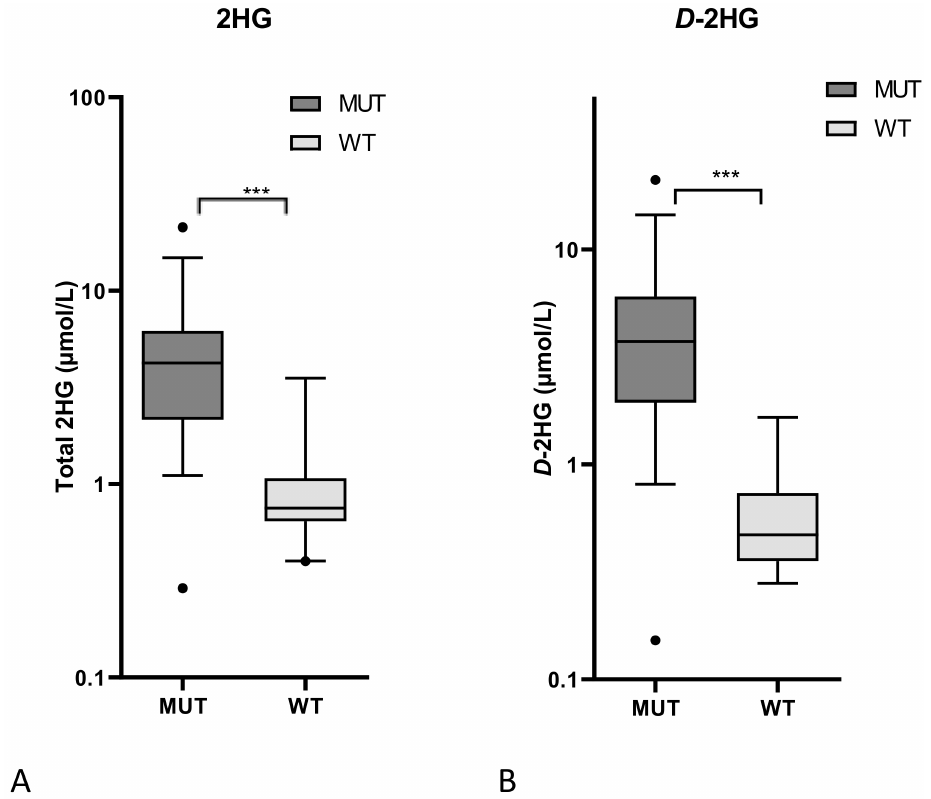
Figure 3. Serum concentrations of ( A ) total 2HG and ( B ) D -2HG was 5.6 ± 1.3 µ mol/L and 5.3 ± 1.2 µ mol/L in patients with an IDH1 -mutated tumor and 1.0 ± 0.2 µ mol/L and 0.6 ± 0.1 µ mol/L